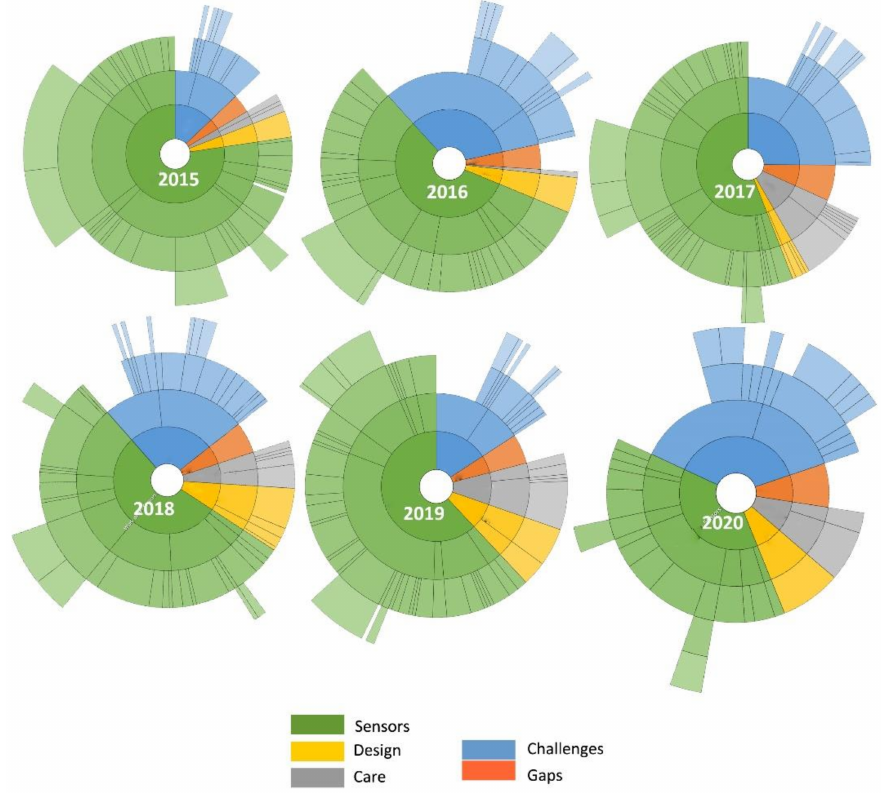
Figure 2. Visualization results on design, sensors and healthcare performed between 2015 and